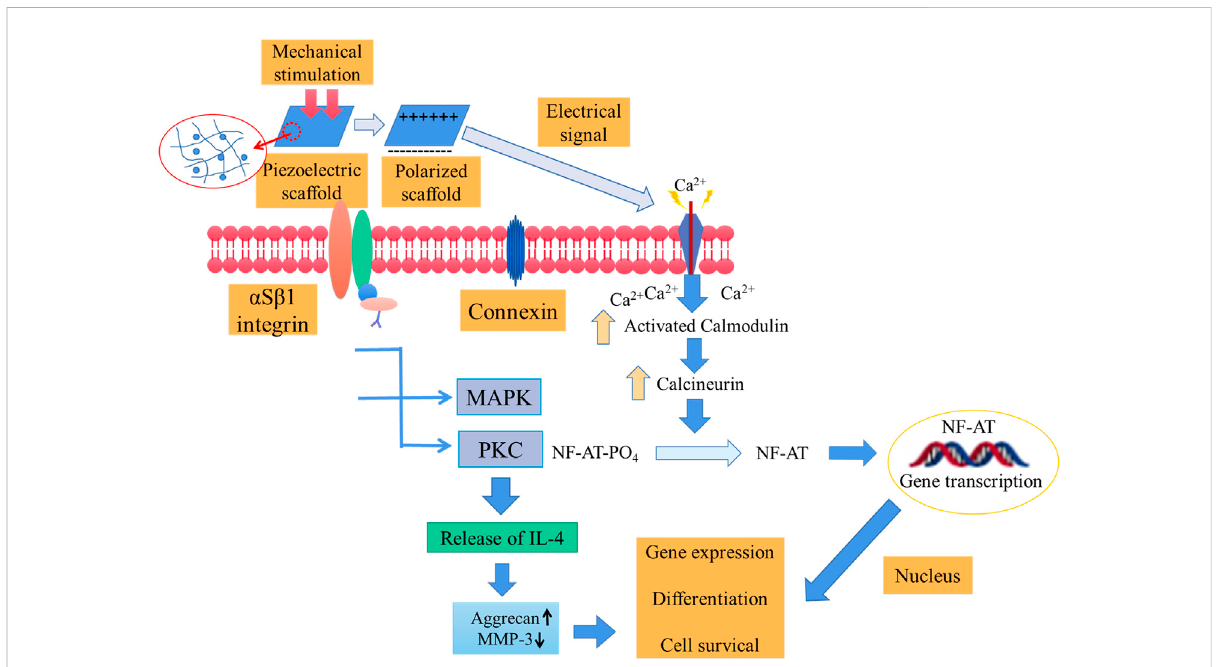
FIGURE 1 Schematic diagram of the activation of signal transduction pathways in response to electrical and mechanical stimulation. Mechanical stimulation is transformedinto electrical signals to activate voltage-gated Ca 2+ channels. The further increaseinthe intracellular Ca 2+ concentration activates the calcium-modulated protein which then further activates calcineurin (calcium and calmodulin-dependent serine/threonine protein phosphatase). The activated calcineurin can dephosphorylate NF-AT and transfer it to the nucleus, where it acts as a transcription factor together with other related proteins. Additionally, mechanical stimulation can activate mechanical receptors in the membrane, thereby activating PKCandMAPKsignalingcascades.Thesecascadesleadtothesynthesisofproteoglycans,andtheinhibitionofIL-1andproteoglycanscanbebroken down (Jacob et al., 2018).